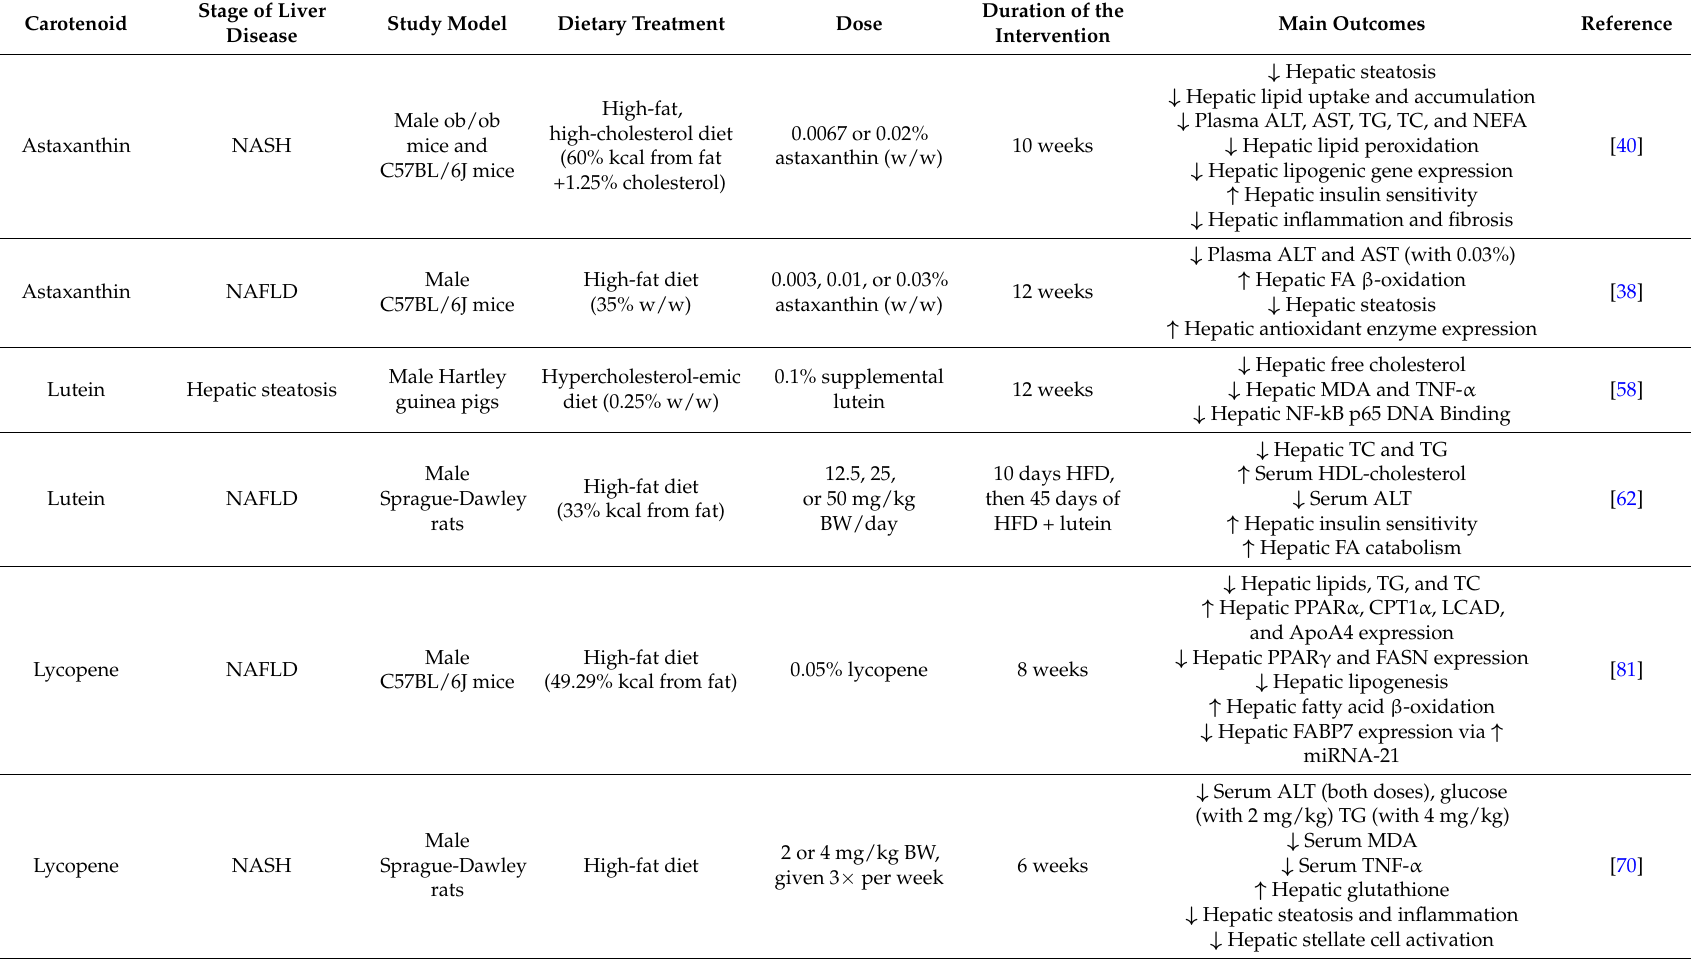
Table 1. Summary of studies where carotenoids had a beneficial effect on Hepatic Steatosis in Animal and Cell Models.